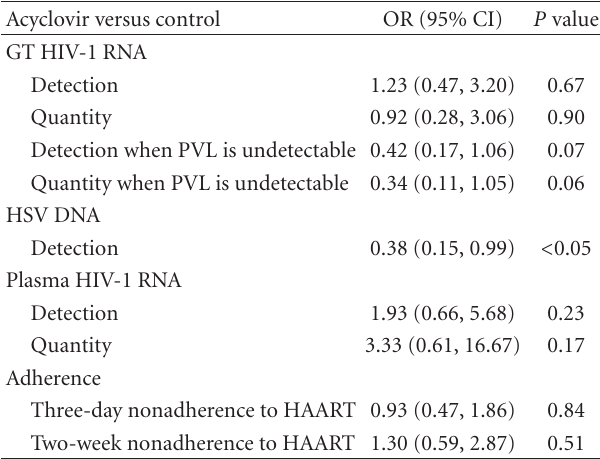
Table 3: Primary and secondary outcomes analysis. Acyclovir versus control